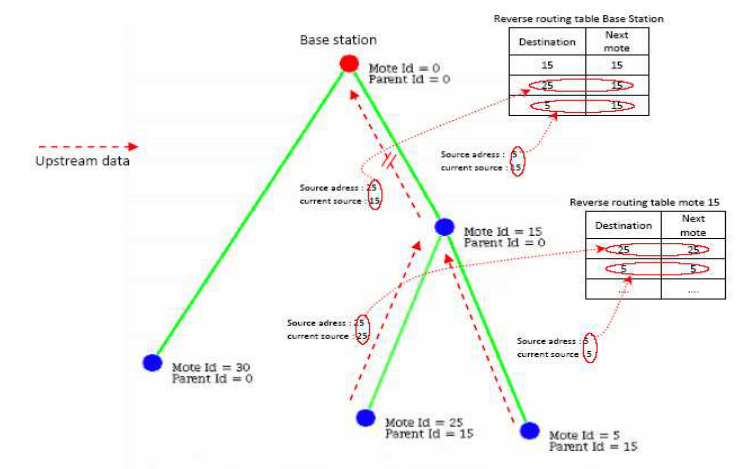
Figure 2. Reverse routing